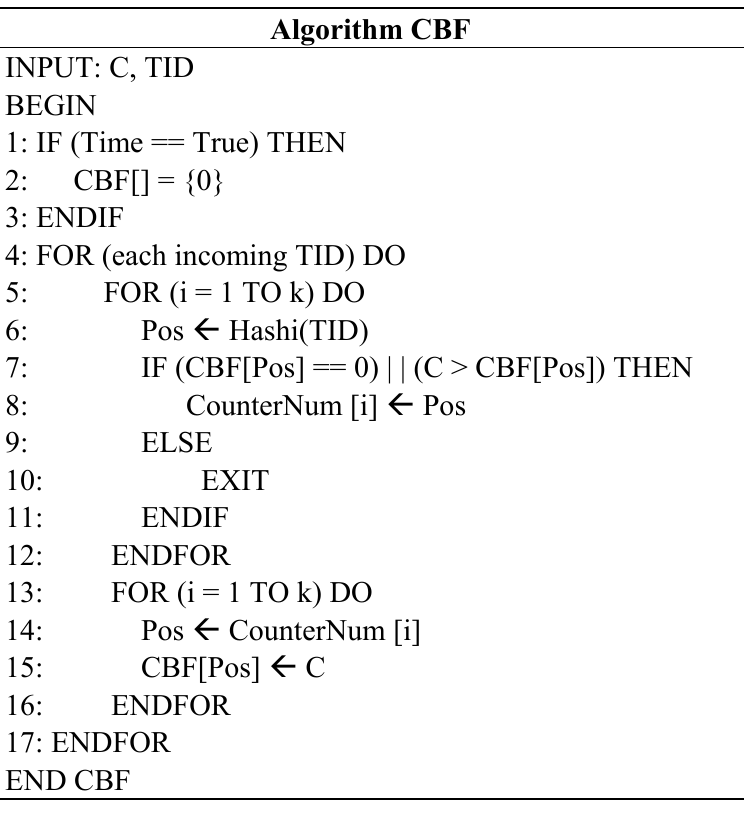
Algorithm 1. RFID duplicate readings filtering